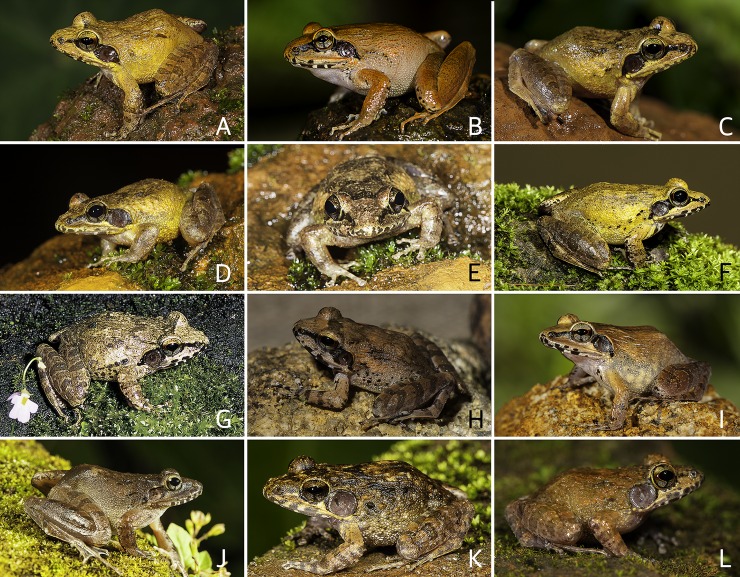
Indirana semipalmata group in life.(A–C) I. chiravasi. (A) An adult male (not preserved), from Amboli. (B) An adult female (SDBDU 2012.2124), from Amboli. (C) An adult male (SDBDU 2012.2125), from Amboli. (D–F) I. duboisi. (D, E) An adult male (SDBDU 2014.2517), from Agumbe. (D) Dorsolateral view. (E) Frontal view. (F) An adult male (SDBDU 2011.1399), from Charmadi Ghats. (G–H) I. gundia. (G) An adult male (SDBDU 2008.433), from Kempholey. (H) An adult male (SDBDU 2002.1115), from Kempholey. (I) Indirana paramakri sp. nov., holotype, an adult female (ZSI/WGRC/V/A888), from Suganthagiri. (J) I. salelkari, an adult female (SDBDU 2011.1330), from Dandeli, dorsolateral view. (K–L) I. semipalmata. (K) An adult female (SDBDU 2015.3033), from Parambikulam. (L) An adult male (SDBDU 2015.3014), from Singappara.